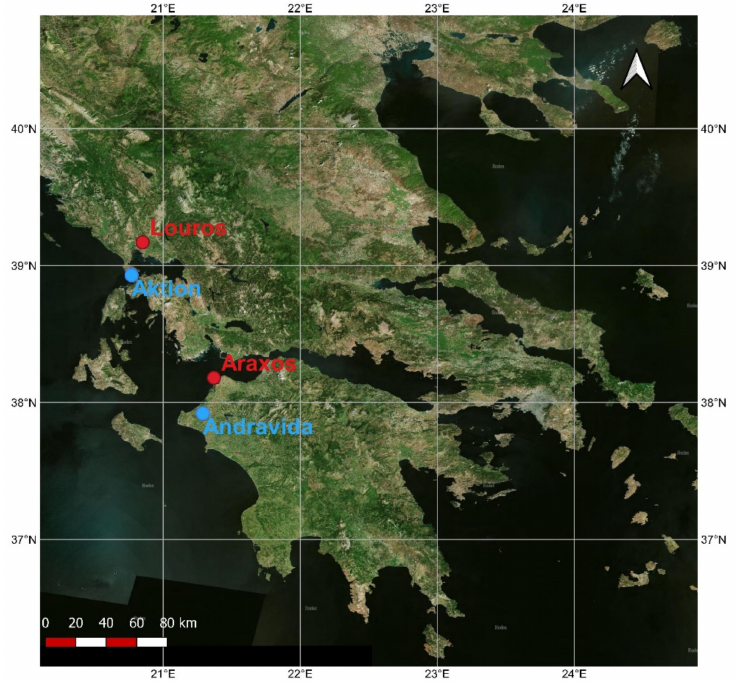
Figure 1. Map of Greece with the two study sites indicated with red dots and the locations of the meteorological stations with blue